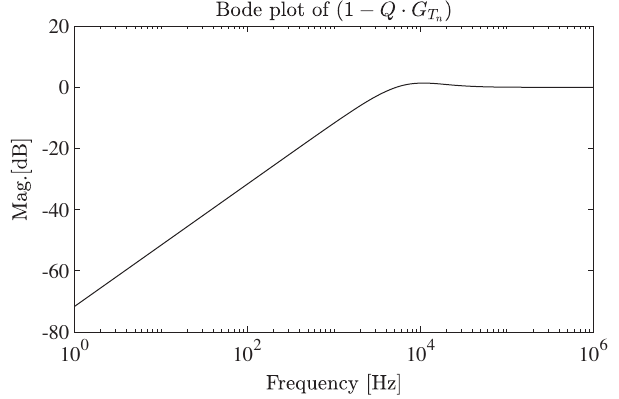
. In the frequency n j < 1 . As a result, the n FIG. 18. H ∞ norm of Δ ð s Þ Q ð s Þ . The restrictions for the uncertainties are given in Table II.